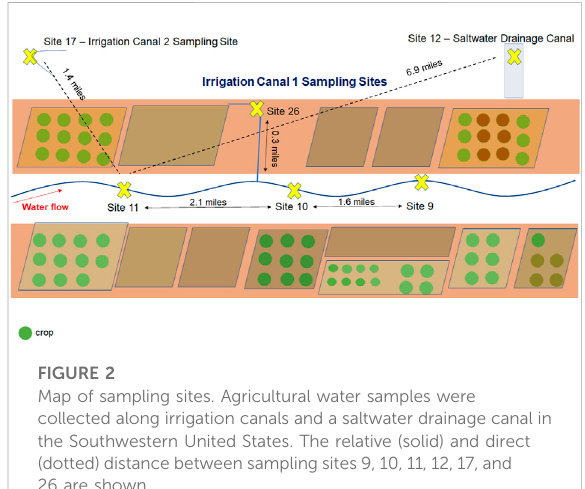
FIGURE 2 Map of sampling sites. Agricultural water samples were collected along irrigation canals and a saltwater drainage canal in the Southwestern United States. The relative (solid) and direct (dotted) distance between sampling sites 9, 10, 11, 12, 17, and 26 are